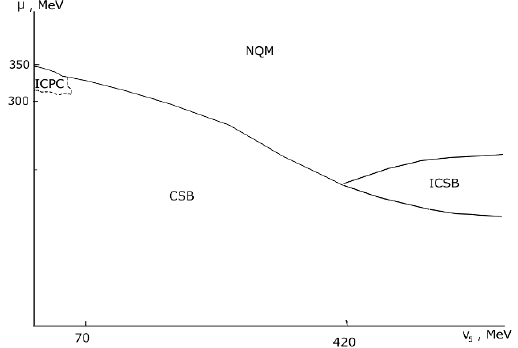
Figure 1 . Combined schematic ( (cid:23); (cid:22) )-phase diagram at (cid:22) 5 = 0 and (cid:23) 5 = 0. Here CPC denotes the homogeneous charged pion con- densation phase, ICPC denotes the inhomoge- neous charged pion condensation phase, CSB and ICSB denotes homogeneous and inhomo- geneous phase with broken chiral symmetry, NQM is the normal quark matter phase, where charged pion condensate is zero and quarks have small masses.